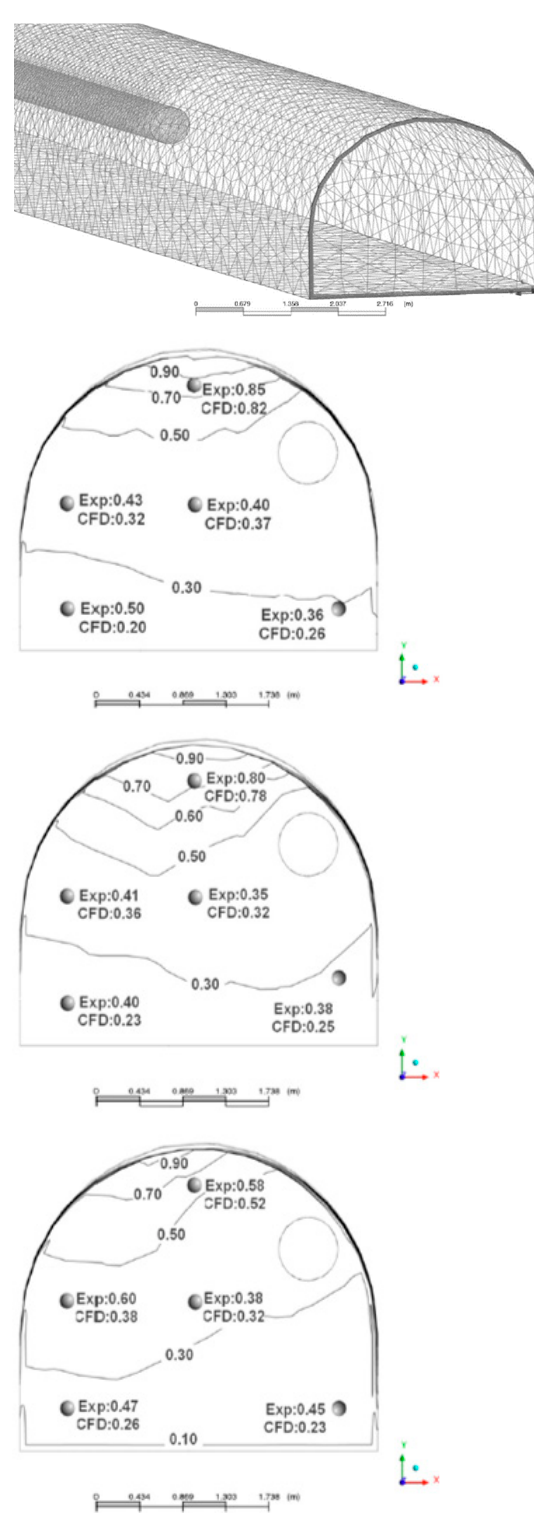
Figure 4. Grid generated for calculation and comparison between the experimental and numerical results (m/s) [17]. (Reprinted with permission from ref. [17]. Copyright 2009 Elsevier B.V.).